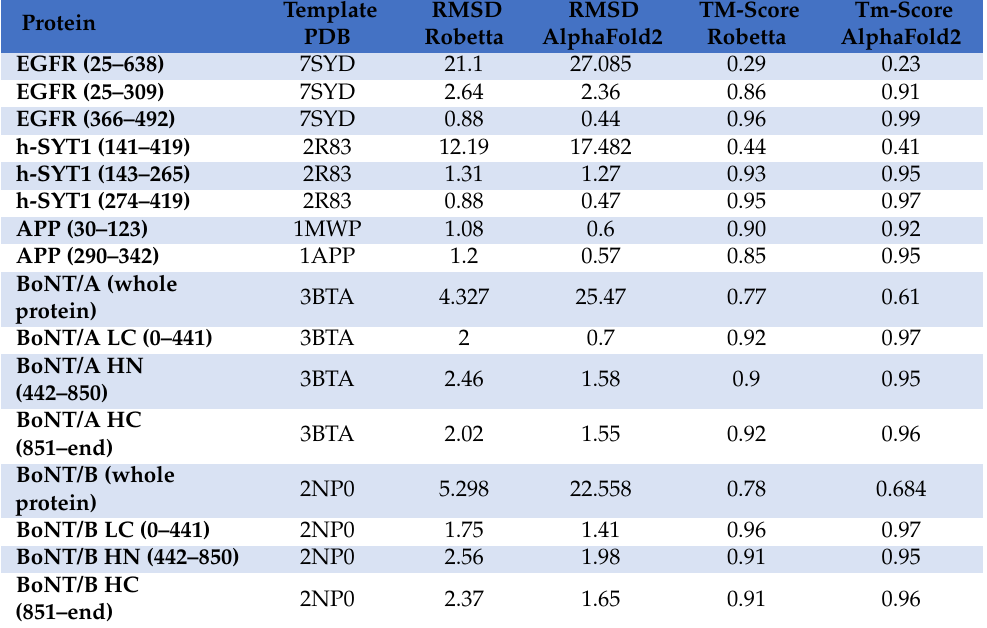
Table 1. Root mean square deviation (RMSD) and template-modeling score (TM-score) values for each AlphaFold2 and Robetta model according to their corresponding experimental structures. The RMSD is the measure of the average distance (in Å) between the backbone atoms of superimposed proteins. TM-score lies between 0 and 1, where 1 indicates a perfect match between two structures (thus the closer to 1 the